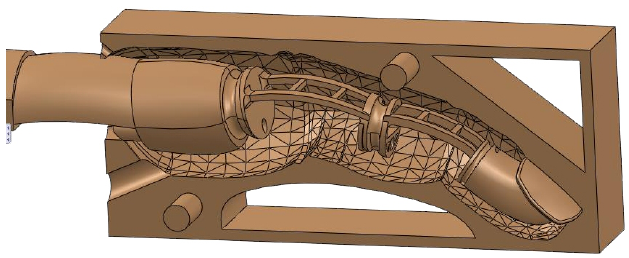
Figure 6. The internal surfaces of the mold are created from 3D scan of a human